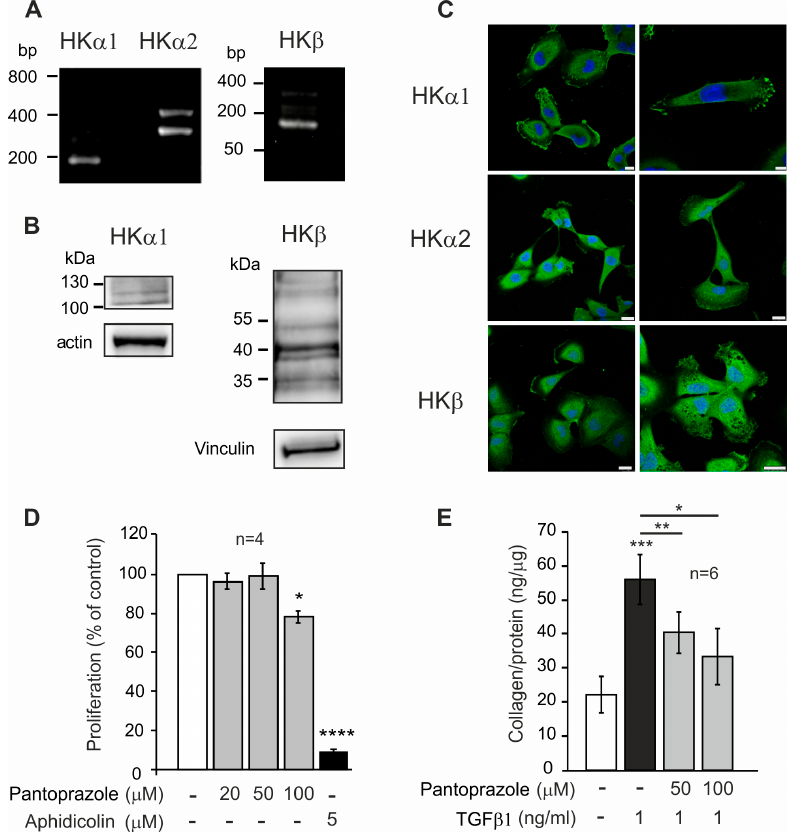
Figure 7. Expression and function of H + , K + -ATPase in human pancreatic stellate cells PaSC. ( A ) Representative gel of ATP4A (HK α 1), ATP12A (HK α 2) and ATP4B (HK β ) mRNA expression. ( B ) Representative western blot of HK α 1 and HK β protein expression. Loading controls were β -actin and vinculin. ( C ) Immunolocalization of HK α 1 (Calbiochem 119101, 1:100), HK α 2 (C384-M79, 1:300) and HK β (Sigma A274, 1:100) is shown in green. DAPI (blue) was used to stain the nuclei. Scale bars indicate 25 µm. ( D) Effect of pantoprazole on PaSC proliferation with 100 µM pantoprazole (*P = 0.0153) and Aphidicolin (5 µM) was used as a negative control (****P < 0.0001), one sample t-test corrected for multiple comparison with Holm-Bonferroni method. ( E ) Effect of pantoprazole on collagen production induced by TGF- β 1 (1 ng/ml) alone (***P = 0.0002), or combined with pantoprazole 50 µM (**P = 0.0017) and 100 µM (*P = 0.0153), paired t-test. Data are shown as means ± s.e.m. from the indicated number of independent experiments. 3.